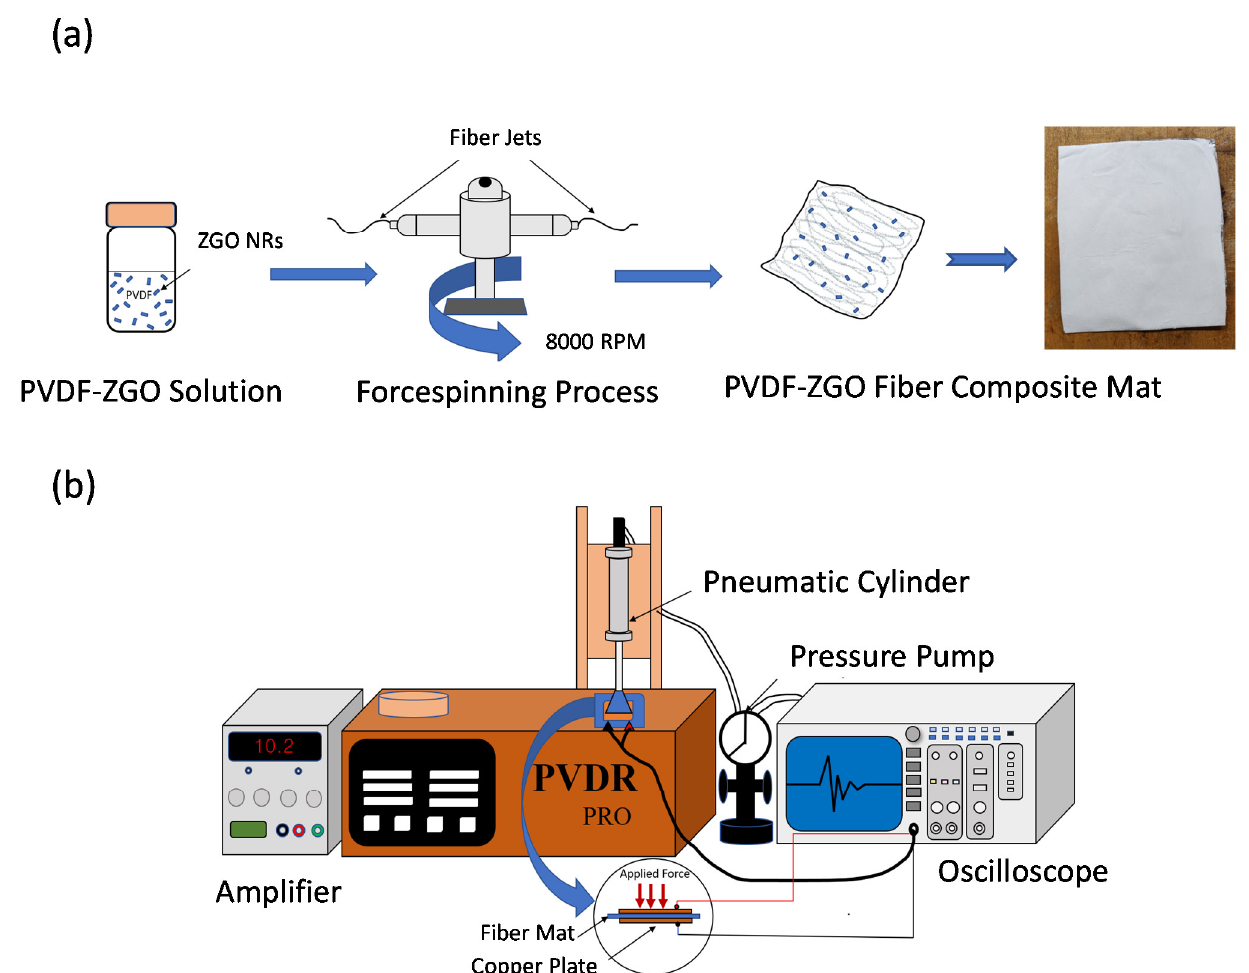
Figure 1. ( a ) Schematic representation of the preparation of ZGO-PVDF fiber composite based mats and ( b ) the pneumatic cylinder and oscilloscope set-up for piezoelectric testing.